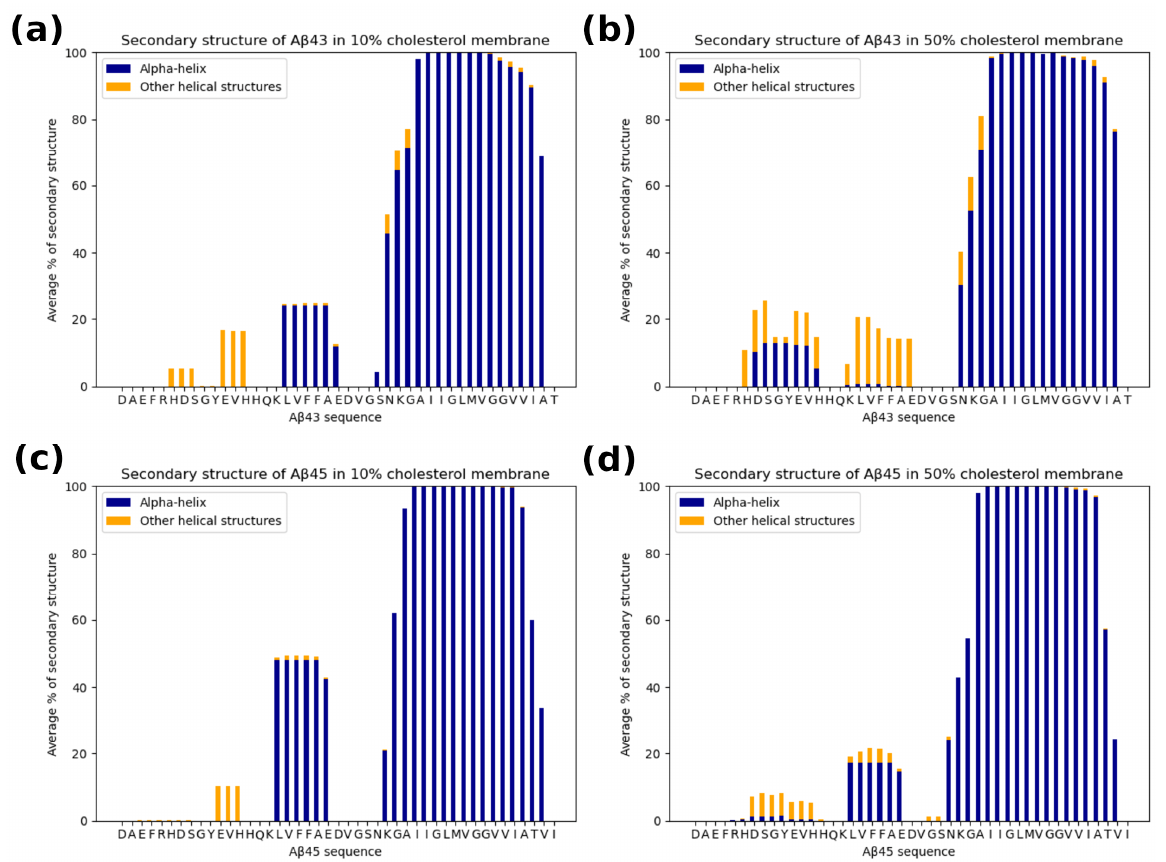
Figure 12. The average secondary structure of the substrate A β 43 and A β 45 during MD simulations in 10% and 50% of cholesterol. Each panel is an average of four MD simulations. ( a ) A β 43 substrate in 10% cholesterol membrane; ( b ) the same in 50% cholesterol membrane; ( c ) A β 45 substrate in 10% cholesterol membrane; ( d ) the same in 50% cholesterol membrane.